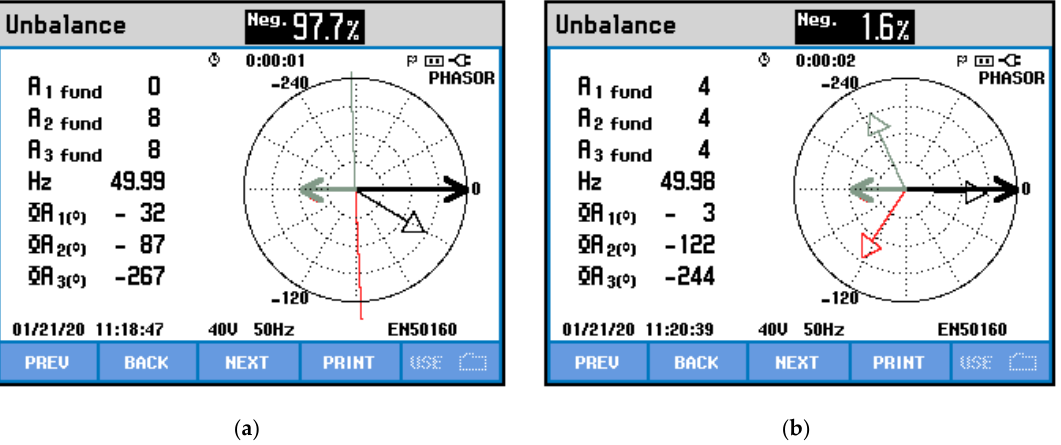
Figure 28. Unbalance ratio and phasors diagram of the three-phase currents at the secondary of the V/V transformer (when one load section is loaded): ( a ) before compensation; ( b ) after compensation.